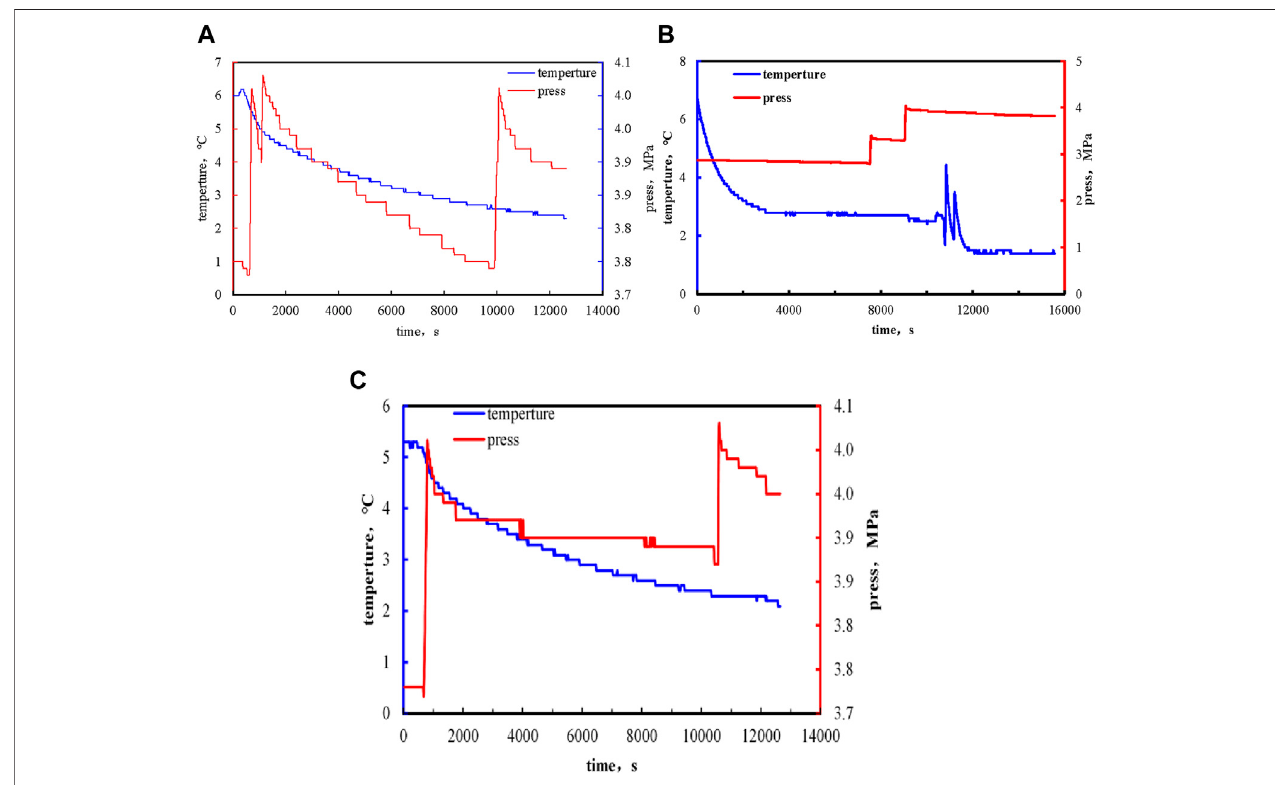
FIGURE 3 | Temperature and pressure curve of methane hydrate formation. ( A :10rad/min; B :20rad/min; C :30rad/min).